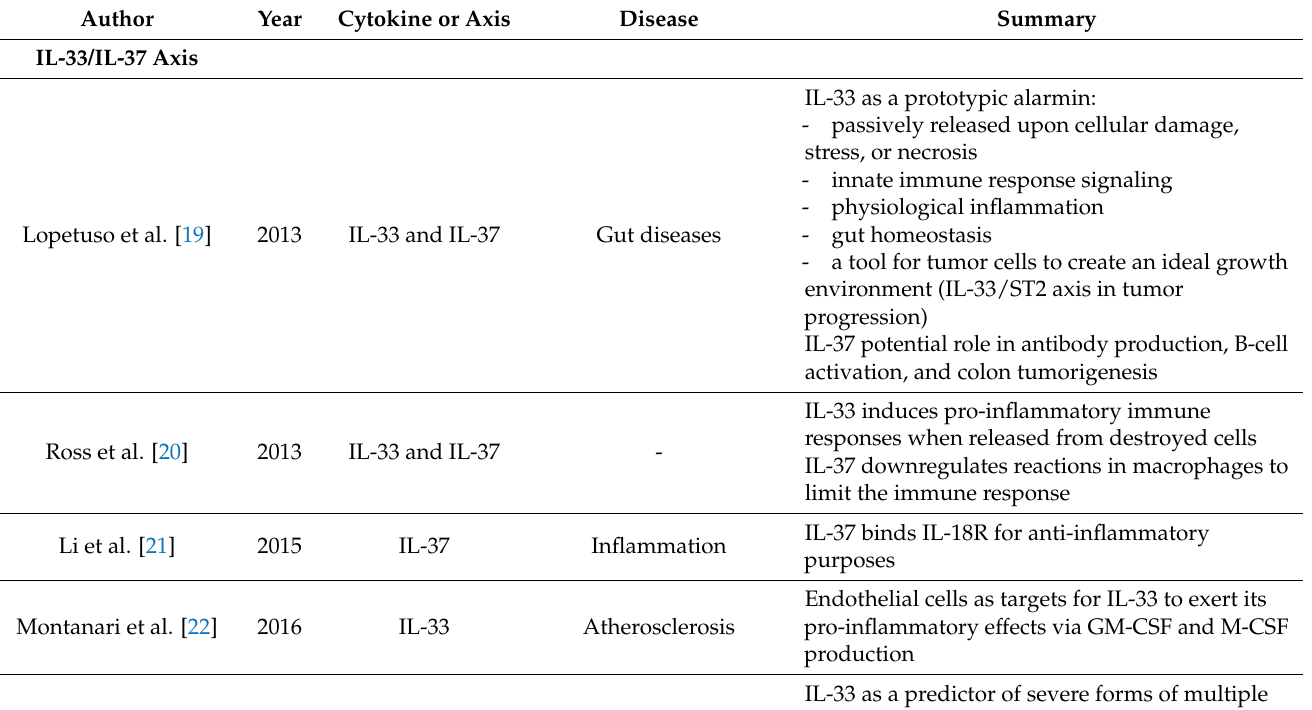
Table 1. Collection of articles included in the review and divided into three sections: IL-33/IL-37 axis, cutaneous diseases, and allergic